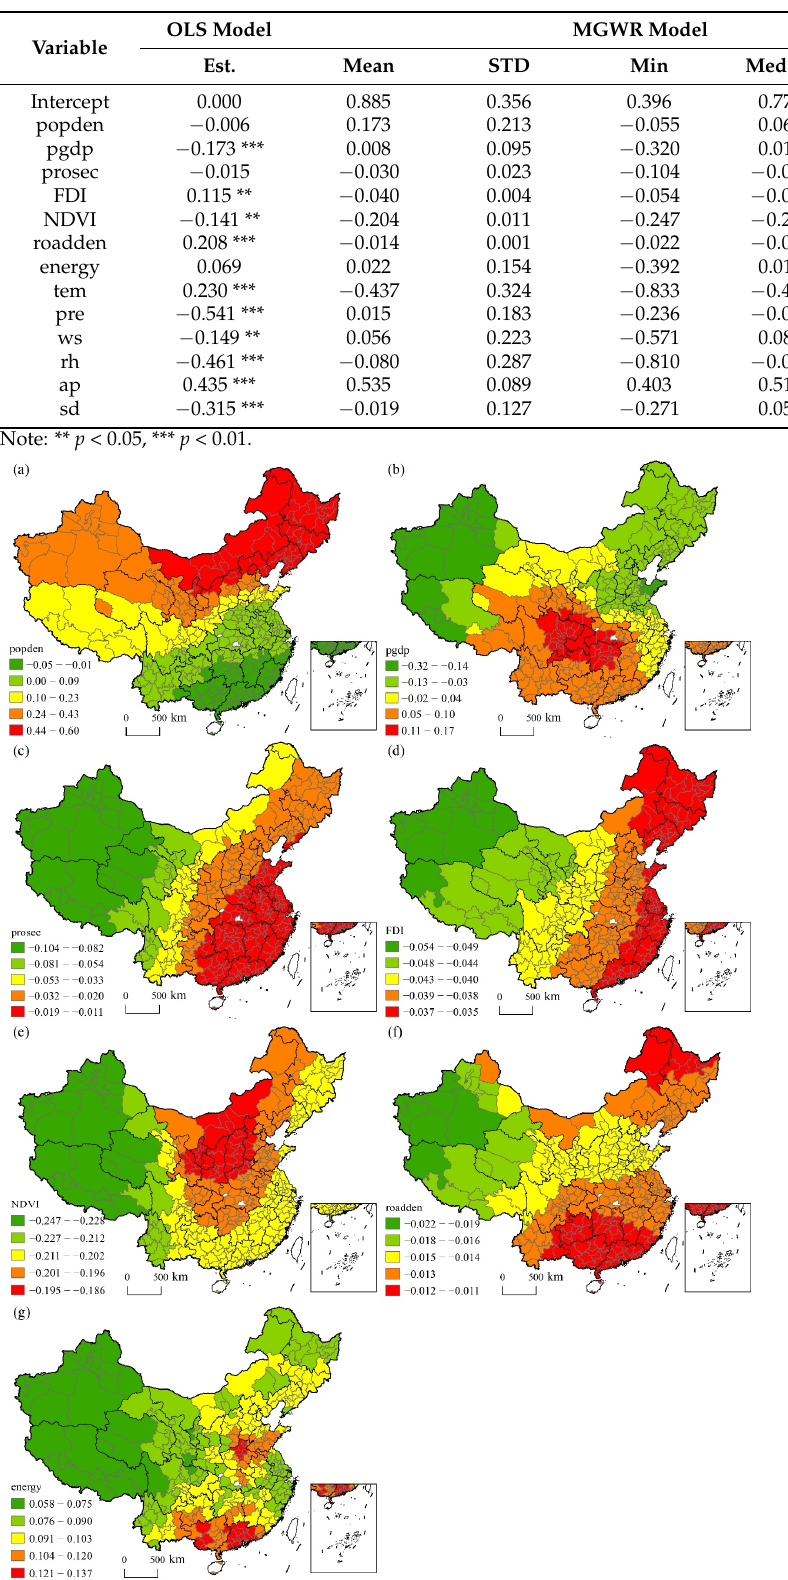
Figure 6. Spatial heterogeneous effects of socioeconomic factors: ( a ) population density, ( b ) per capita GDP, ( c ) proportion of secondary industry added value in GDP, ( d ) proportion of foreign direct investment in GDP, ( e ) NDVI, ( f ) road density and ( g ) energy